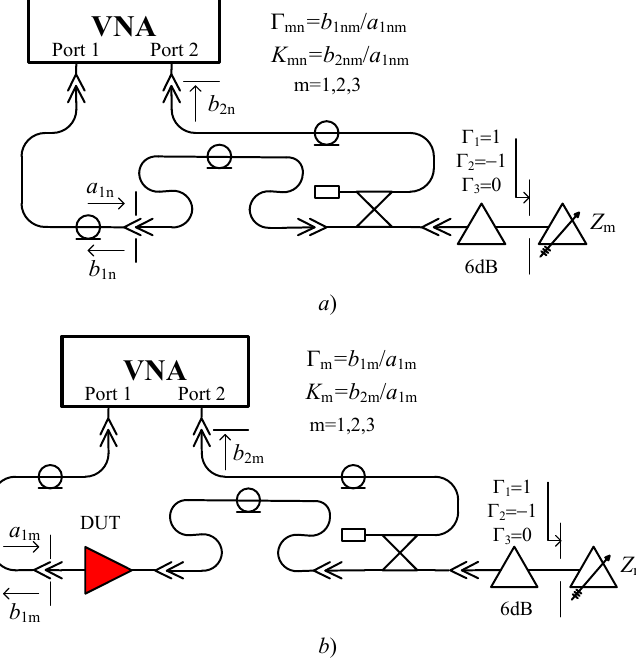
Fig. 1. Simplified scheme for nonlinear S-parameters measuring of a contact device in a coaxial line: a - calibration process; b - measurement process